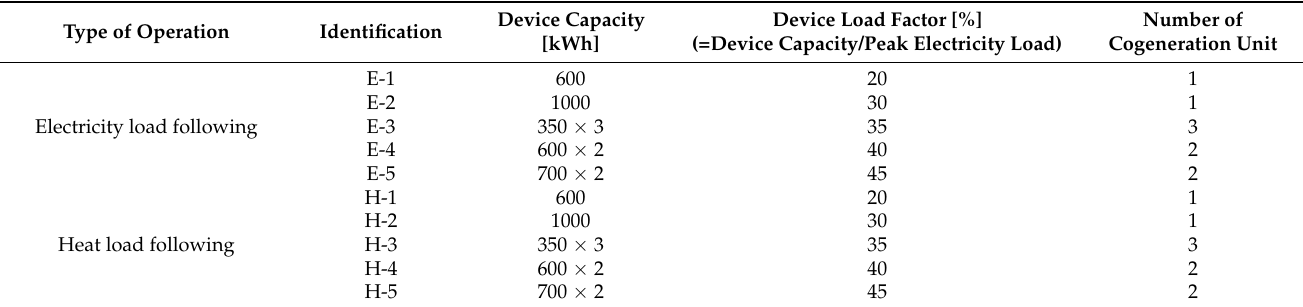
Table 5. System and operating conditions for the